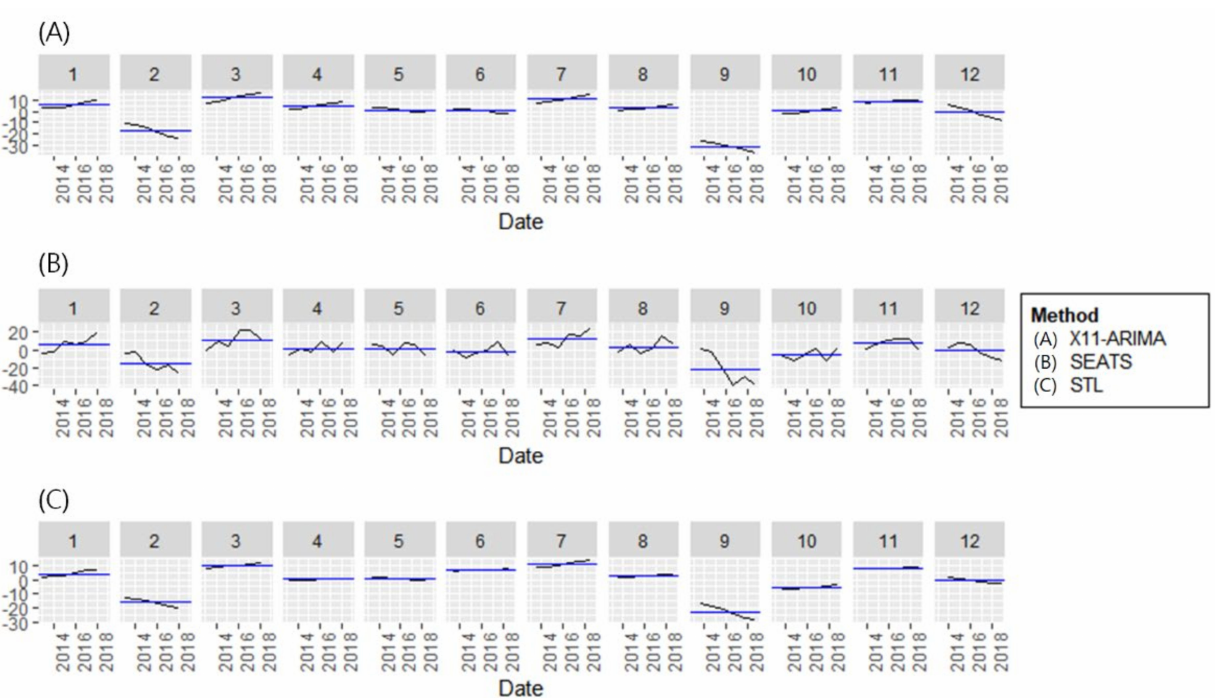
Figure 3. Trends in monthly lower limb amputation rates of diabetic foot patients analyzed using three different time series decomposition methods. ( A ) X11 − ARIMA: integrated autoregressive moving averages processes, ( B ) SEATS: seasonal extraction in ARIMA time series, and ( C ) STL: seasonal and trend decomposition using Loess methods. (Note) Black line: Adjusted amputation rate by each methods, Blue line: Mean of adjusted amputation rate by each